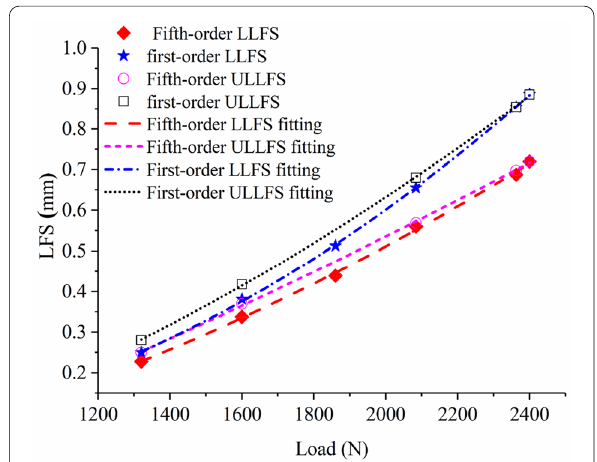
Figure 9 Lateral feature size during loading (LLFS) and unloading (ULLFS) versus load